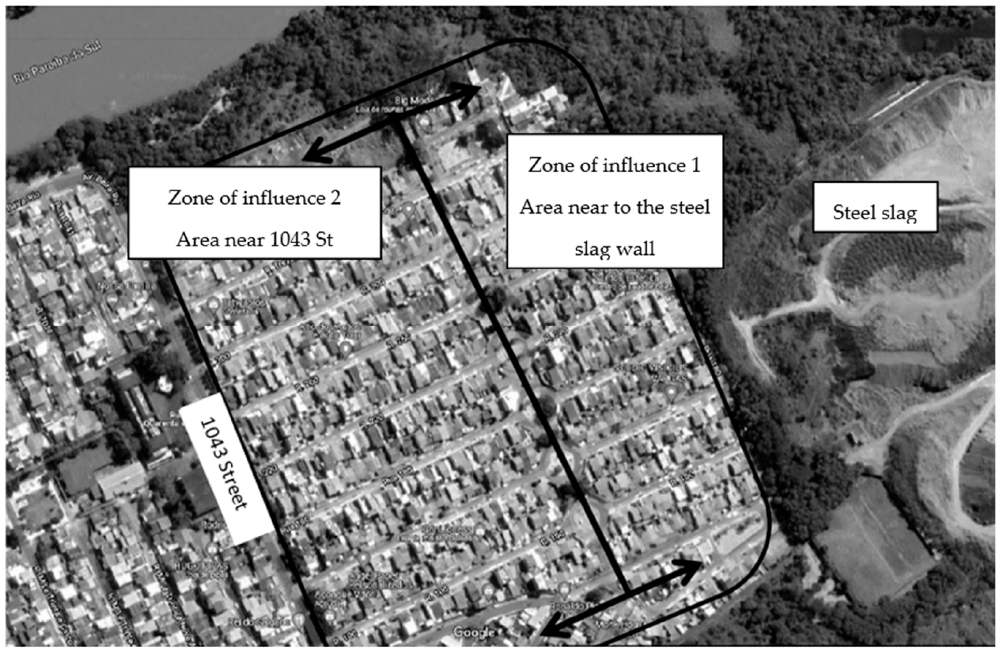
Figure 1. Delimitation of the influence zone concerning benzene and toluene exposure in the Volta Grande IV condominium.